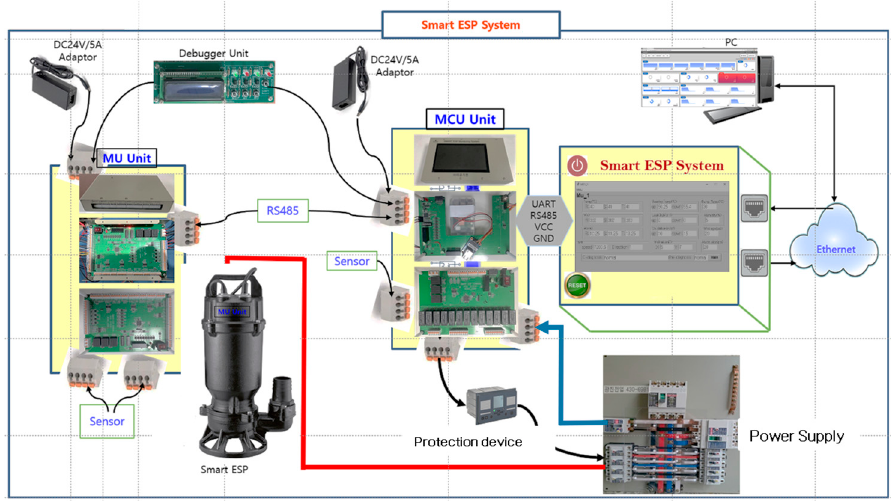
Figure 8. Behavioral test of ESP.